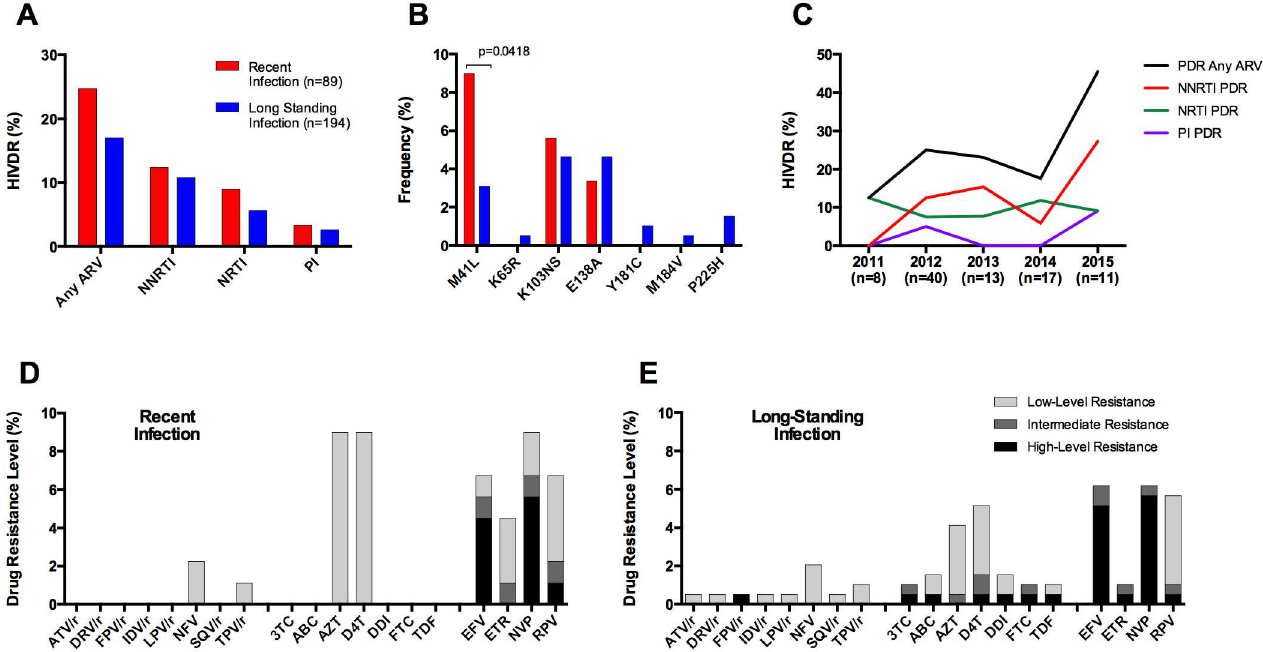
Fig 6. PDR in individuals with recent and long-standing HIV infection. PDR was estimated using the HIVdb tool from Sanger sequences. Individuals with drug resistance were definedas those with at least low-levelresistance (Stanford penalty score (cid:21) 15) to any drug of the corresponding class. A. PDR levels by antiretroviral drug class. B. PDR levels by drug resistance mutation; relevant mutations for PDR to the most widely used ART regimens in Nicaraguaare shown. C. PDR trends by year of enrolment in recently infected individualsonly. D-E PDR levels by antiretroviral drug in individuals with recent and long-standing infection; drug resistance levels were classified accordingto the Stanford Score, as explained for Fig 3. The number of patients enrolledby year was 17, 88, 69, 61, and 48 for 2011, 2012, 2013, 2014, and 2015 respectively.